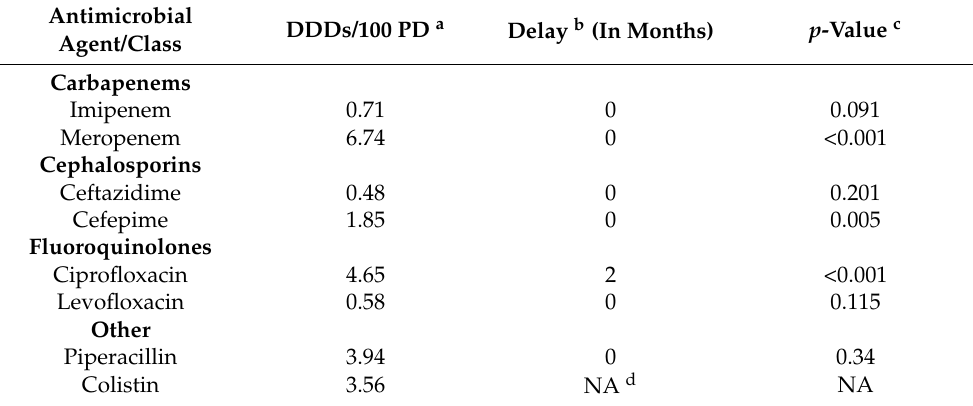
S, susceptible; I, intermediate; R, resistant. Table 2. Antibiotic use expressed as the mean of monthly Defined Daily Doses per 100 patient-days (DDDs/100 PD) between January 2014 and December 2017 and the association in univariate time series analysis with its antibiotic-resistant Pseudomonas aeruginosa .